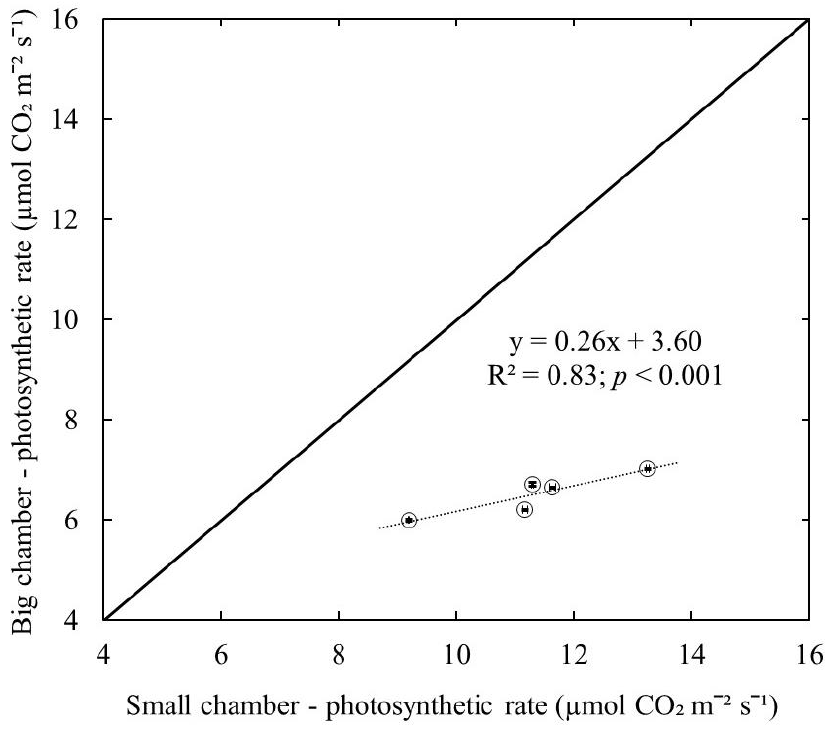
Figure 5. Relationship between leaf photosynthetic rates measured by the Li-Cor small leaf chamber and by the big leaf chamber for wild blueberry plants. The solid line represents the 1:1 linear trendline. The dashed line represents a linear relationship fitted to the data by linear regression analysis ( p < 0.001).